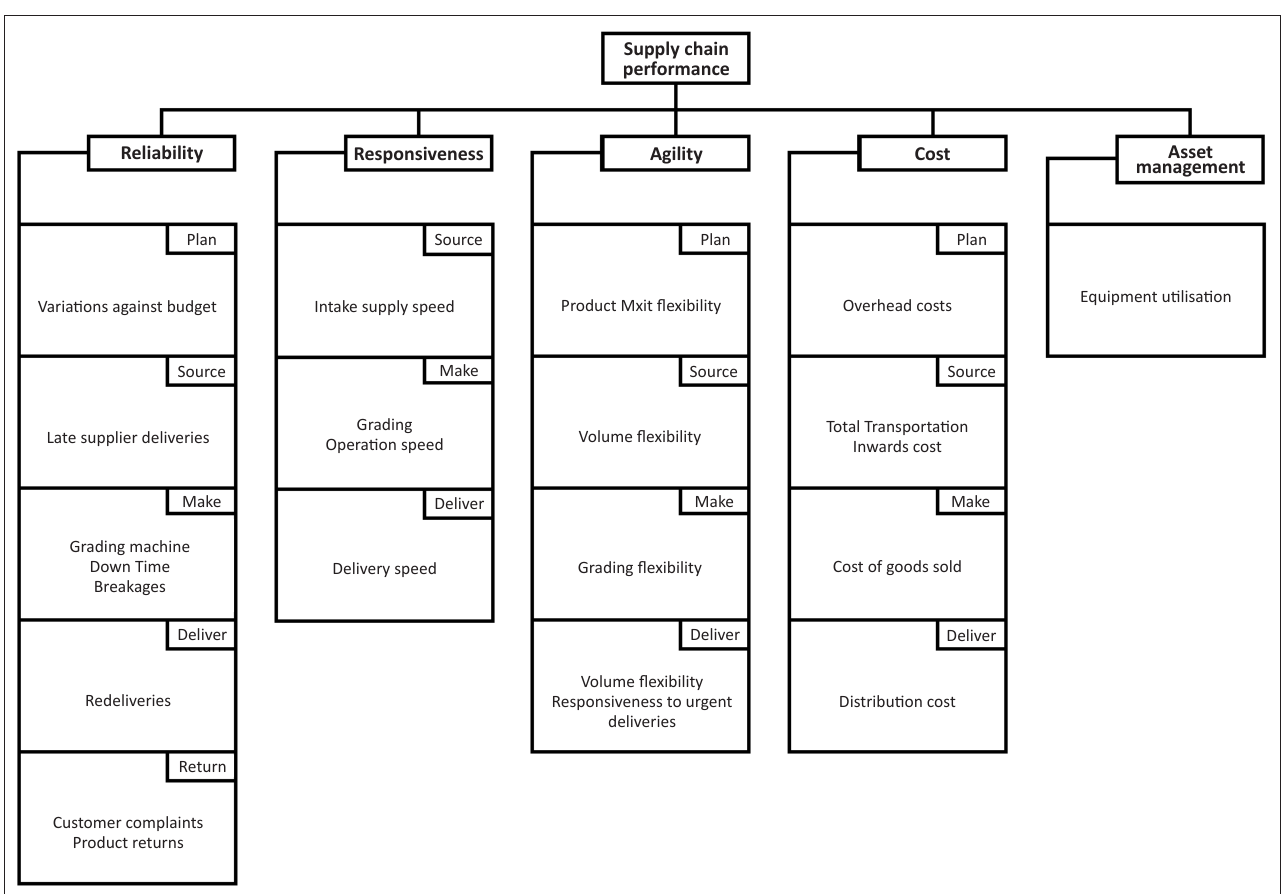
FIGURE 2: The developed